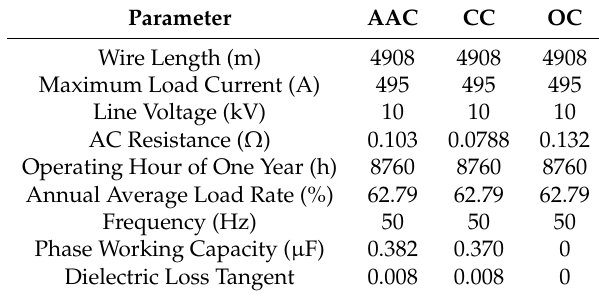
Table 7. Physical parameters in Case 2.